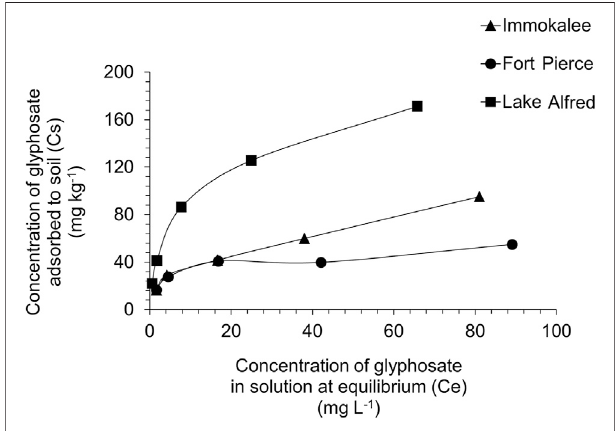
FIGURE 2 | Freundlich adsorption isotherm plots of glyphosate in Florida ’ s citrus production soils.